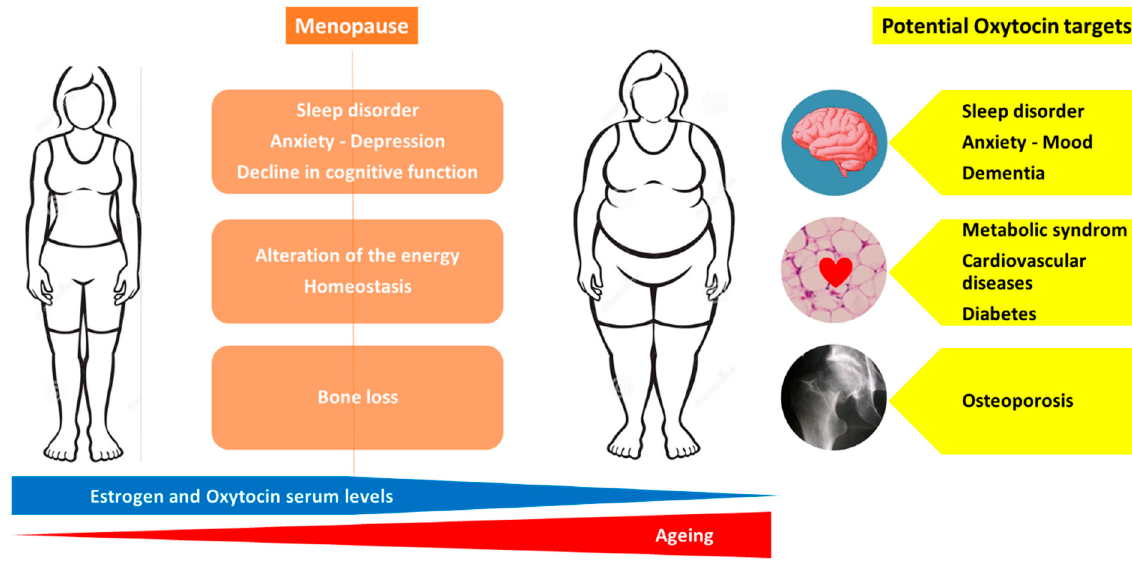
Figure 2. Potential therapeutic targets of oxytocin in menopause-related diseases.